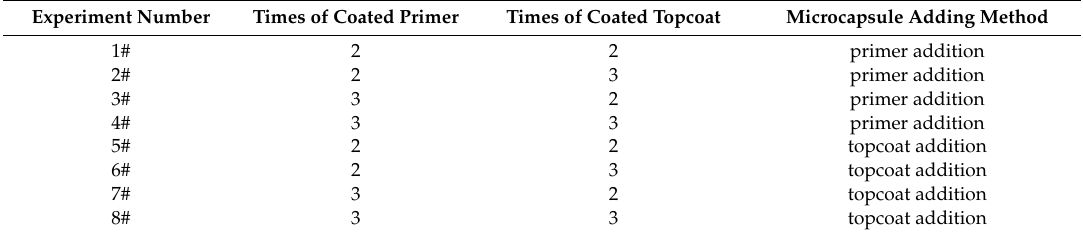
Table 1. Experimental schedule of coating process of the waterborne acrylic coatings with microcapsules.